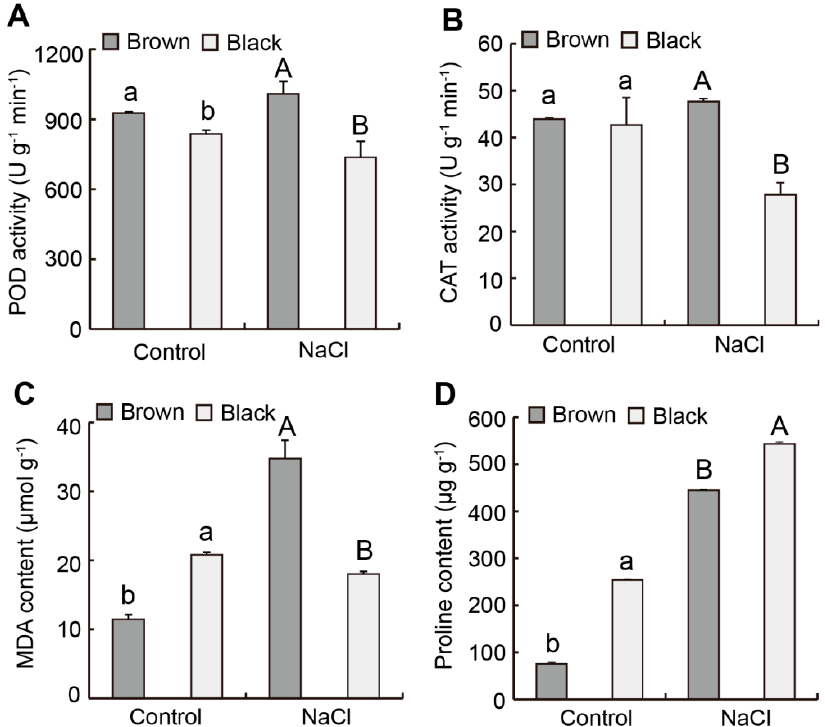
Figure 6. Effect of NaCl on the physiological indexes of dimorphic seeds during germination in S. liaotungensis . ( A ) POD activity. ( B ) CAT activity. ( C ) MDA content. ( D ) Proline content. Different lower-case letters show significant differences between dimorphic seeds during germination in the absence of NaCl solution ( t − test, p < 0.05). Different upper-case letters show significant differences between dimorphic seeds during germination in the presence of 400 mM NaCl solution ( t -test, p < 0.05).